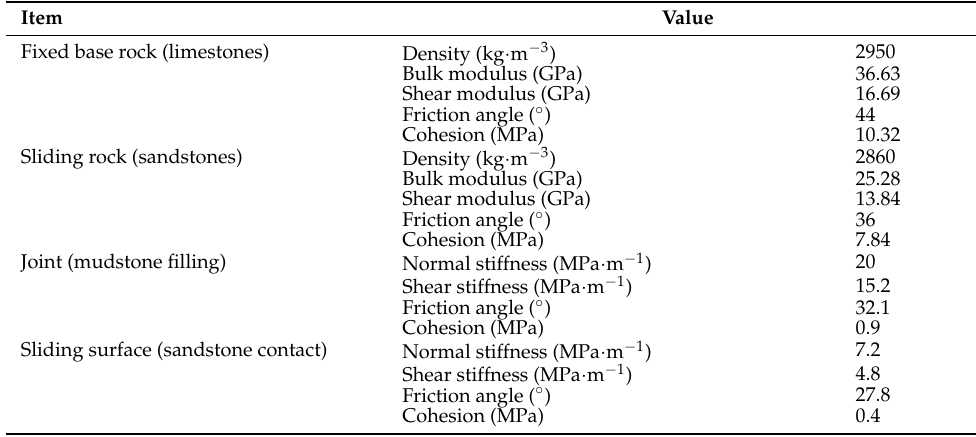
Table 1. Physical and mechanical parameters for the numerical analysis.